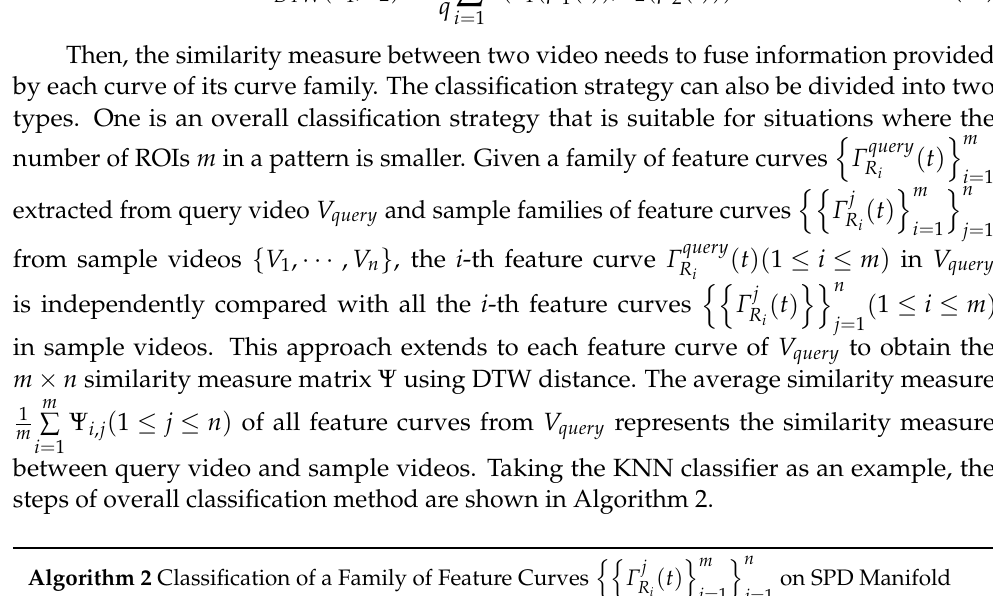
Algorithm 2 Classification of a Family of Feature Curves with Overall Classification